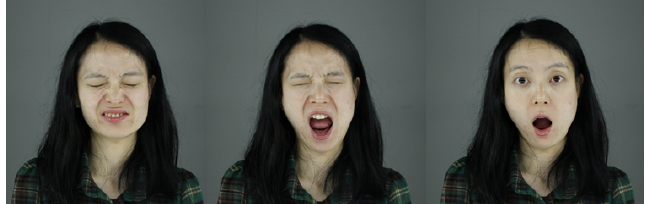
Figure 12. Example facial expressions from out